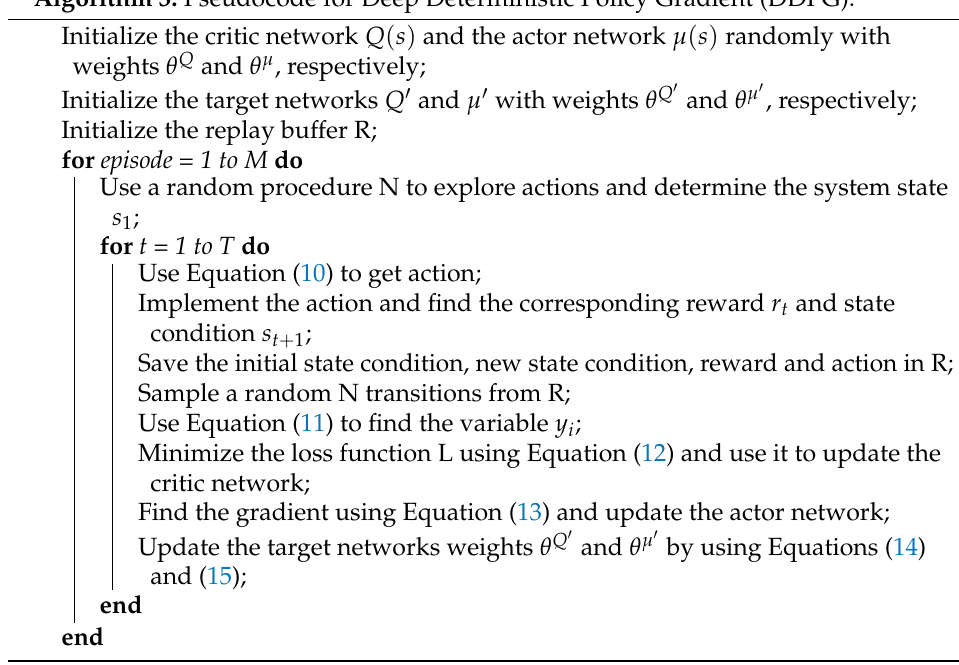
Algorithm 3: Pseudocode for Deep Deterministic Policy Gradient